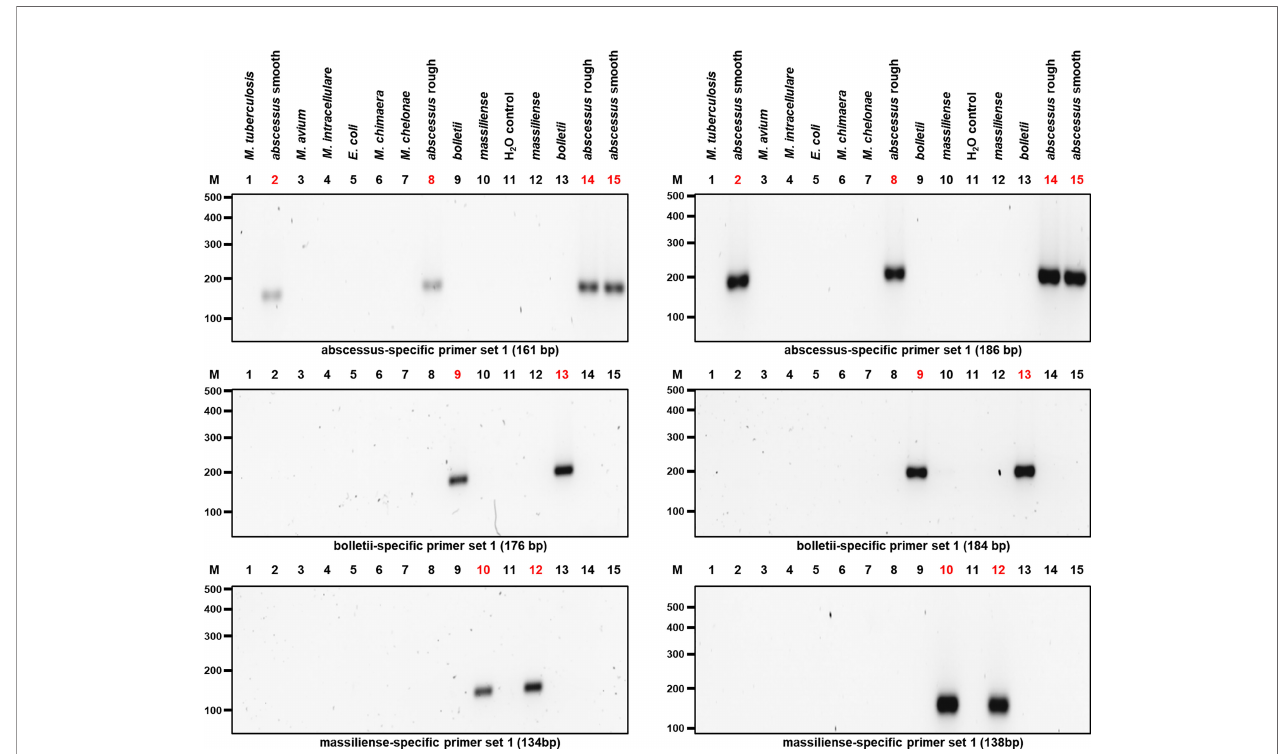
FIGURE 3 | PCR results after optimizing the ampli fi cation of the candidate genes used to isolate the three MABC subspecies. Two different sets of primers pairs as shown in Table 1 were used to differentiate MABC into its subspecies. M. abscessus (rough and smooth morphotypes), M. bolletii , M. massiliense and other bacterial species used as controls including M. chelonae , M. tuberculosis , M. avium, M. intracellulare, M. chimaera , and E. coli were selected. Both M. abscessus strains including rough and smooth morphotypes yielded 161-bp and 186-bp gene amplicons, respectively (Top Panel). In addition, M. bolletii yielded 176-bp and 184-bp gene amplicons, respectively (Middle Panel). Lastly, M. massiliense yielded 134-bp and 138-bp gene amplicons, respectively (Bottom Panel). Each MABC subspecies yielded an ampli fi ed PCR product that was speci fi c to that